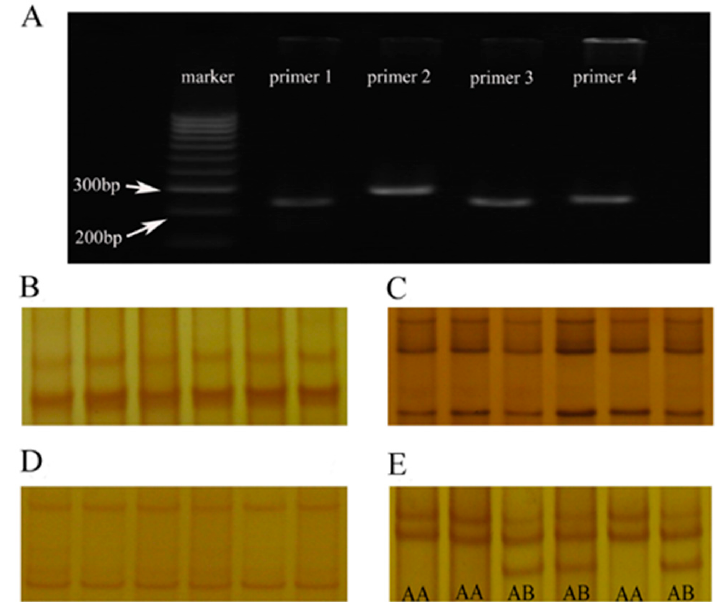
Figure 1. Amplified fragment and SSCP analysis of α -LA gene CDS and their adjacent regions in Chinese Holstein dairy cows. ( A ) 2% agarose gel electrophoresis of PCR amplification products (four pairs of primers) for CDS and their adjacent regions of α -LA gene. ( B – E ) SSCP analysis of PCR products for CDS and their adjacent regions of α -LA gene: (1) the primer 1, primer 2, and primer 3 PCR products had no di ff erence in the SSCP analysis bands; (2) the primer 4 PCR products had two di ff erent bands, named AA and AB. Table 2. SSCP studied the genotype and allele frequency of the α -LA gene in two subgroups of Chinese Holstein cows. Genotypic Frequencies Allele Frequencies p < 0.01 Items AA AB A